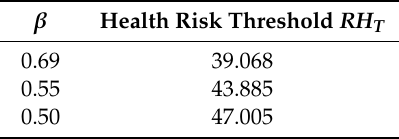
Table 5. Optimal predictive maintenance strategy under di ff erent β values.